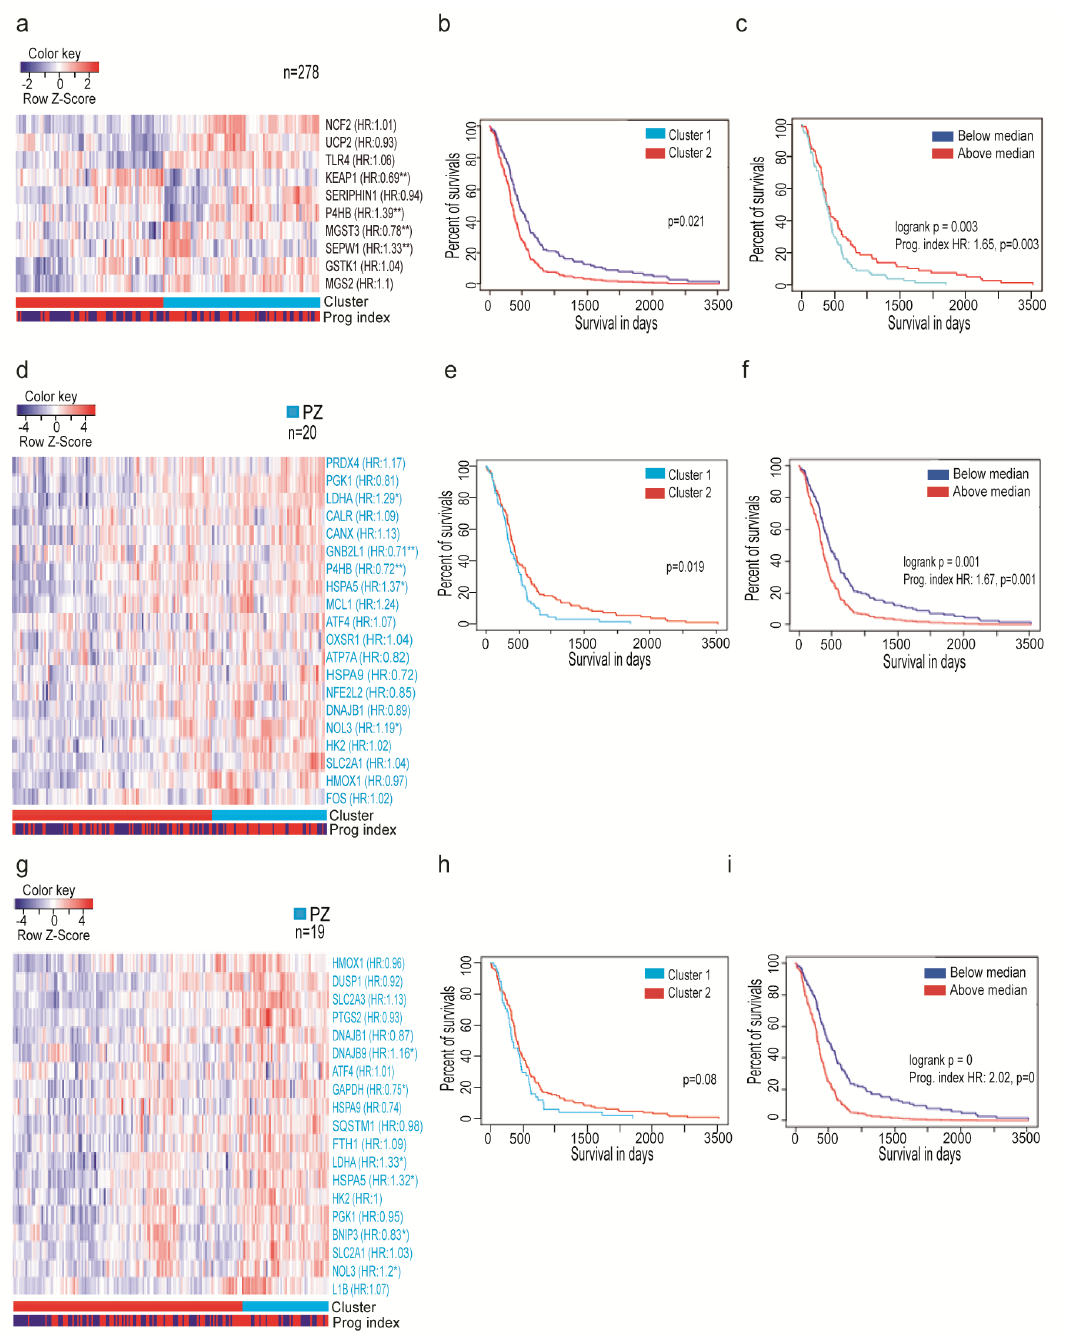
Figure 3. Patient survival is correlated with the expression of oxidative-stress-related genes in the perinecrotic zone: ( a , d , g ) Heatmaps with color annotations according to profile similarity (light blue / red) annotated with prognostic index (red–dark blue). ( b , c , e , f , h , i ) Kaplan–Meier analysis of a full cohort of glioblastoma. Clustering and survival analysis of samples dataset stratified by the status of oxidative stress response genes ( a – c ), top-20 upregulated genes in PZ vs. LE ( d – f ), or vs. CT ( g – i